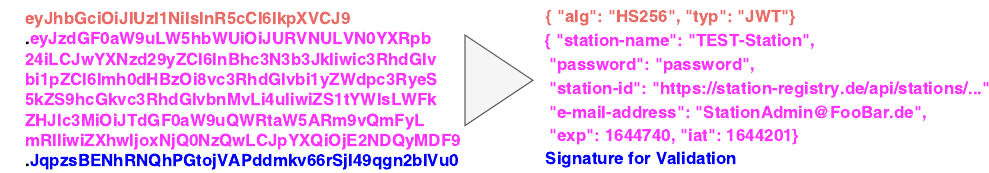
Figure 4. Configuration file for the station. After setting up all necessary configuration items, the CS merges the information into one file. This information enables a station to connect to the central services such as the repository or